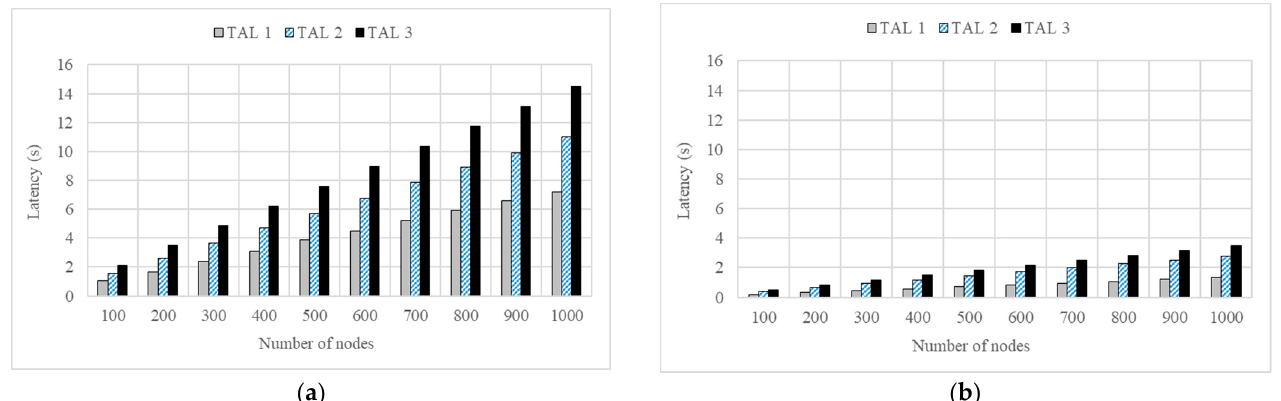
Figure 6. Latency based on TAL: ( a ) CON and ( b ) DAM4SNC models.